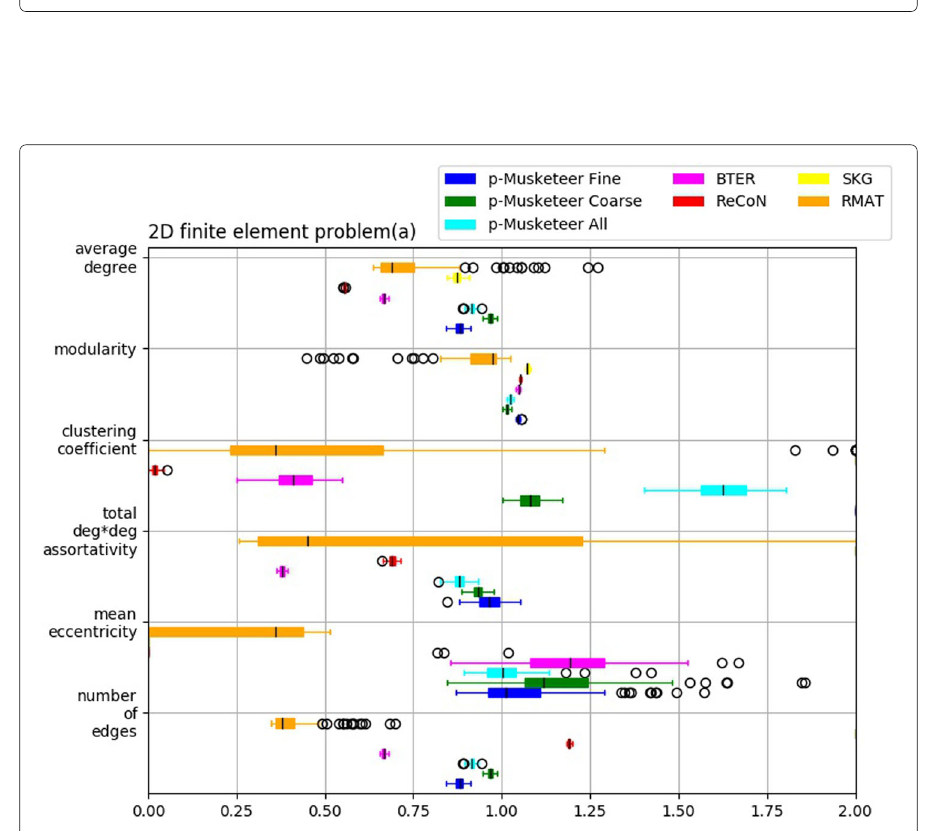
Fig. 14 Computational results on performance of planar Musketeer 2D finite element graph with 1866 nodes and 3538 edges for clustering coefficient, number of edges, mean eccentricity, total degree *degree assortativity, modularity and average